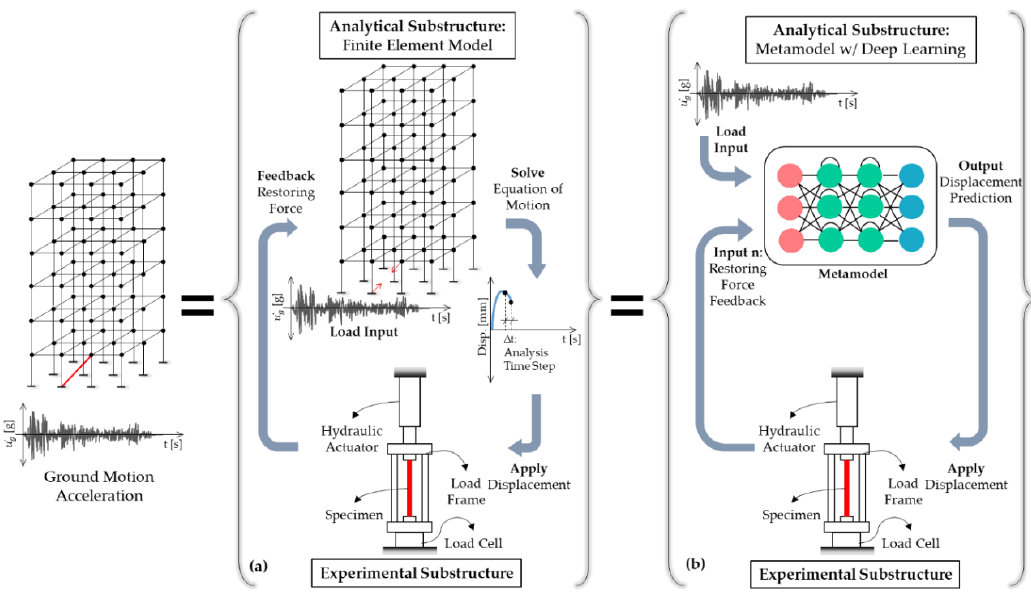
Figure 1. Schematic representation of ( a ) conventional HS with FE model ( b ) HS with metamodel.